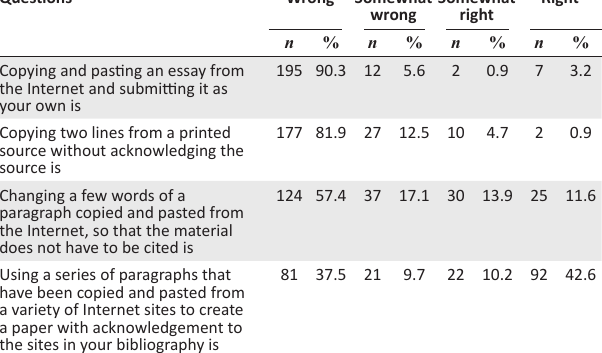
TABLE 2: Plagiarism category.